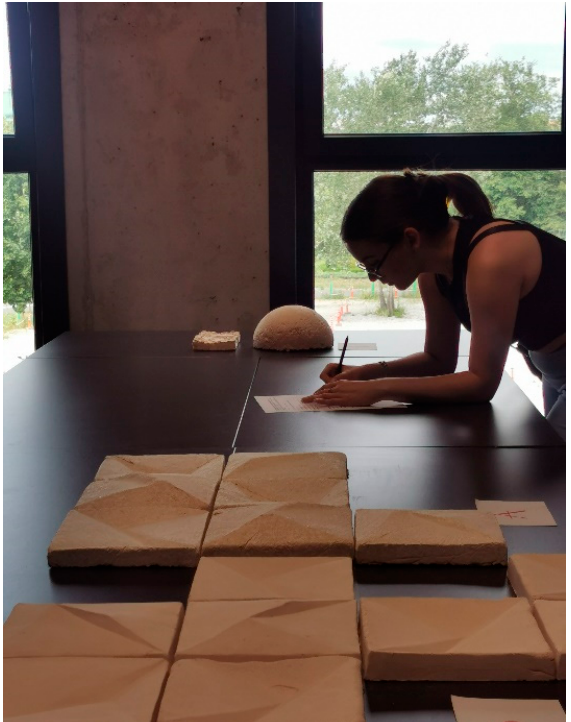
Figure 5. Sample assessment process. Respondents assessed the products individually by typing their answers to the questions on the test forms (photo by A.B.).